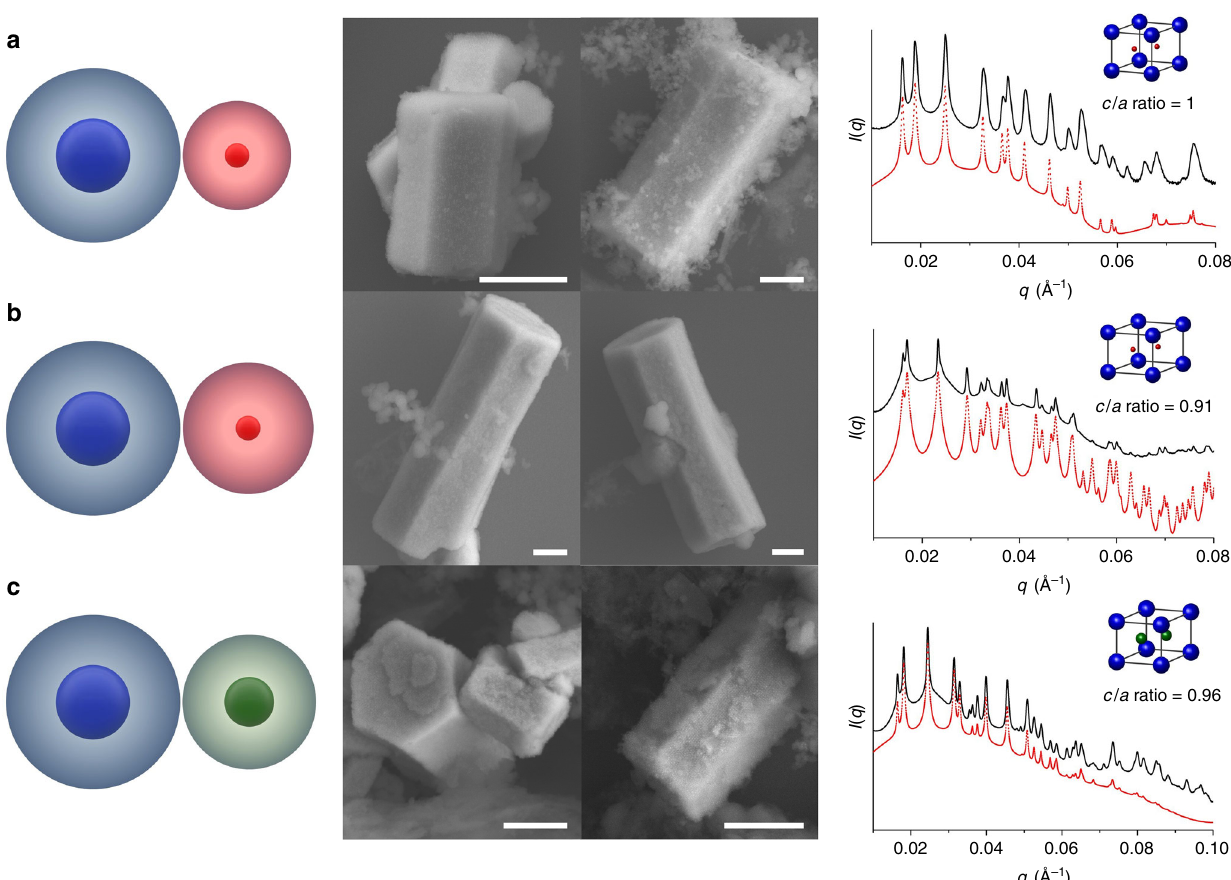
Fig. 2 Hexagonal prisms with varying unit cell compositions. a – c SEM images and one-dimensional SAXS patterns of hexagonal prism microcrystals from an AB 2 lattice synthesized from different sets of PAEs to achieve a range of β / α : a 0.67, b 0.73, and c 0.80 (scheme shown on left). The systems shown in a and b each consist of a pair of nanoparticles; one has an Au core diameter of 15 nm and the other is 5 nm. In the case of the small particle, the hydrodynamic radius was deliberately changed by changing the thickness of the DNA shell so that the β / α in b is greater than in a . The system in c used the same 15 nm Au core PAEs that were used in a and b , but the hydrodynamic radius was varied by changing the Au core diameter of the small particle (10 nm in diameter) so that the β / α in c is greater than in a . In the SAXS patterns, the black trace is the experimentally obtained scattering pattern, and the red trace is the predicted scattering pattern for a model lattice. The lattice parameters from SAXS results were used to calculate the c / a ratio of each unit cell. Scale bars are 1 μ